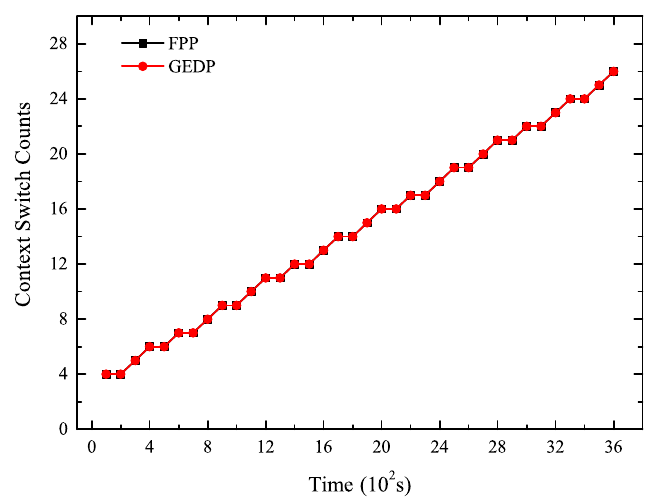
Figure 11. Involuntary context switches of Whetstone.